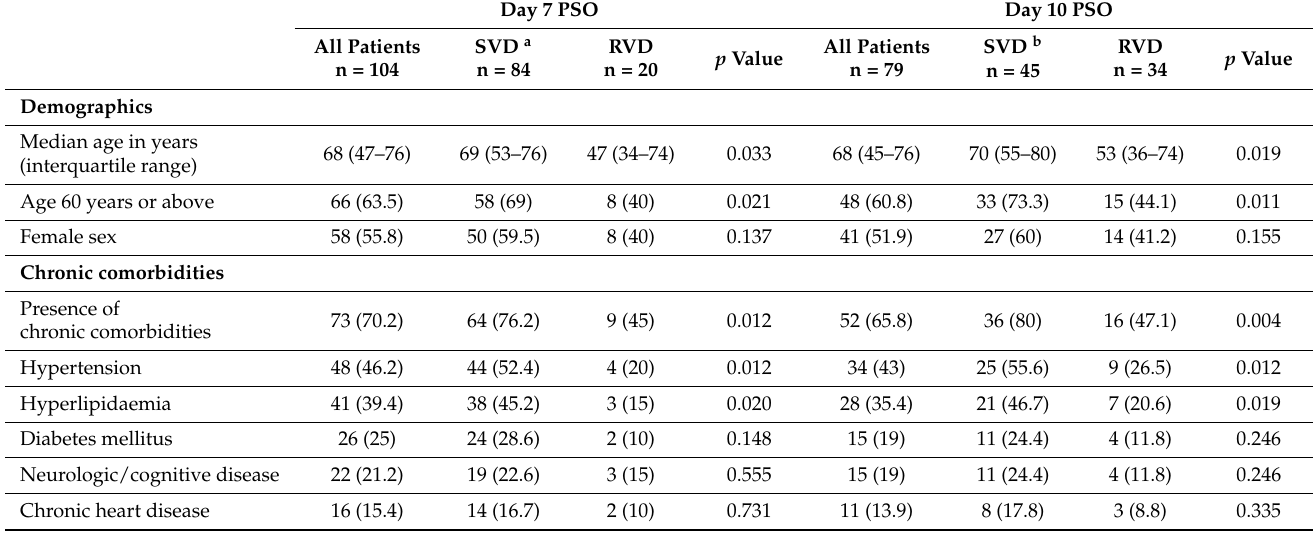
Table 2. Comparison between patients with slow viral decline (SVD) and rapid viral clearance (RVD) on day 7